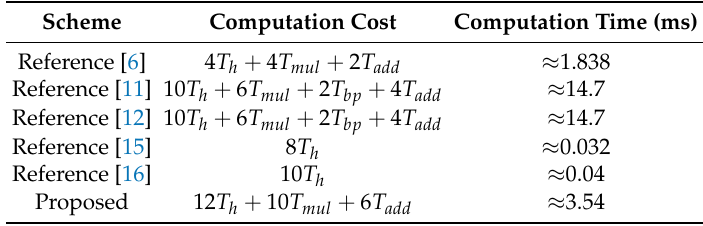
Table 5. Comparison of efficiency.